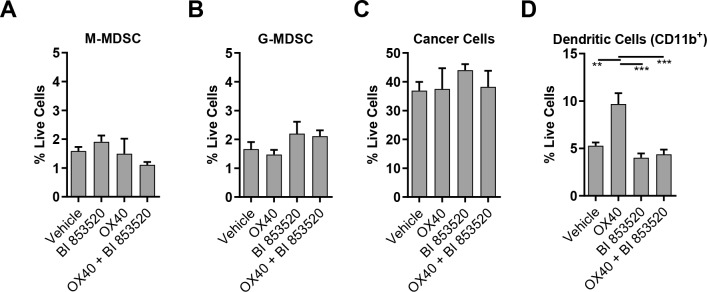
Frequency of immune cell populations in SCC6.2 tumors treated with either Vehicle, OX40, BI 853520 or OX40 + BI 853520.(A – D) Flow cytometry quantification of tumor infiltrating M-MDSCs, G-MDSCs, Cancer cells, and CD11b+Dendritic Cells. Data represented as mean + /- s.e.m. **=p ≤ 0.01, ***=p ≤ 0.001, ordinary one-way ANOVA with Tukey’s multiple comparison. n = 4 tumors per condition.